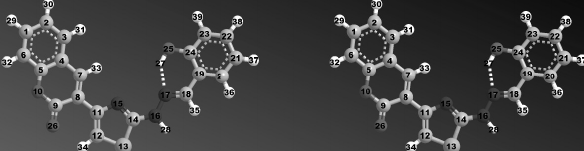
Figure 6. Stereographic view of 1a after global minimization along with the numbering scheme of the atoms. Table 1. Electrochemical data of